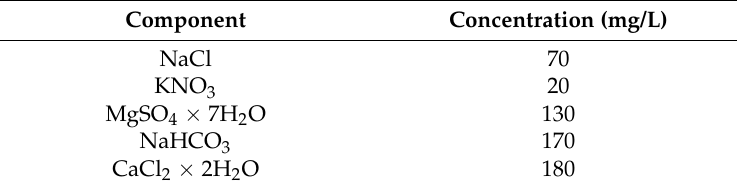
Table 1. Composition of the flavor-free water solution used as